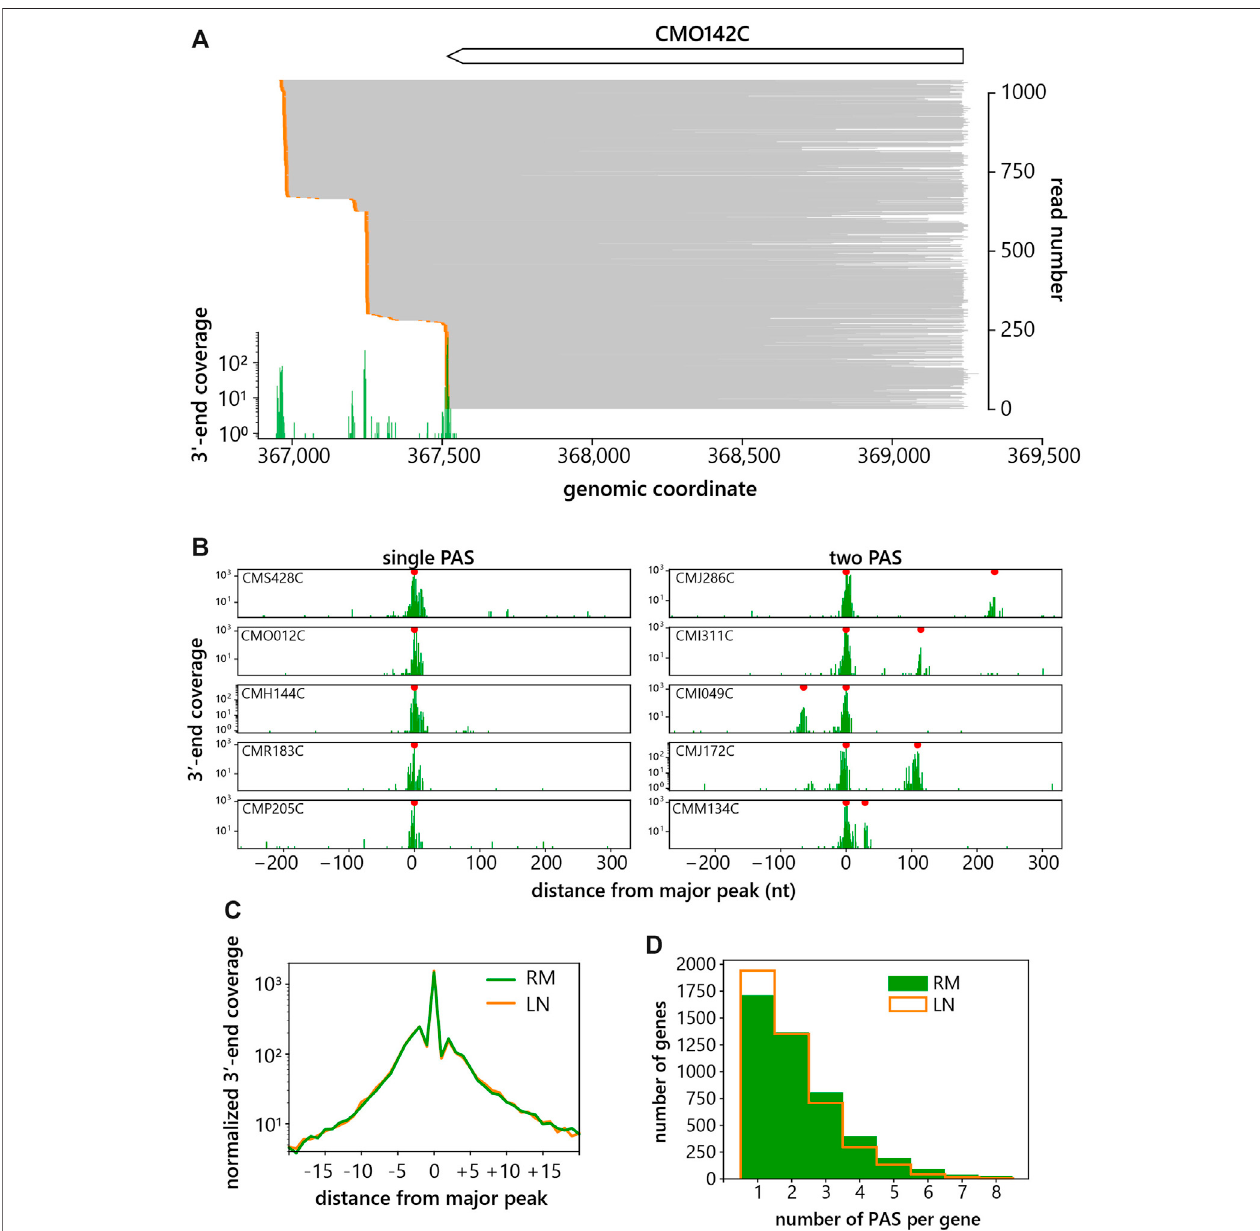
FIGURE 2 | Alternative polyadenylation in C. merolae. (A) Example of a gene CMO142C with at least four PAS ’ s showing aligned reads in gray, 3 ′ -ends in orange andahistogramof3 ′ -endcoverageingreen. (B) Examplesof3 ′ -endcoveragedistributionsforgeneswithoneortwoPAS ’ s.Reddotsindicatecalledpeaksthatpassed the thresholds. (C) Metagene analysis of primary PAS peaks. The major peak is at the position ofnucleotide 0, RM (cid:1) rich media, LN (cid:1) low nitrogen. (D) Histogram of the number of PAS ’ s per gene. RM (cid:1) rich media, LN (cid:1) low